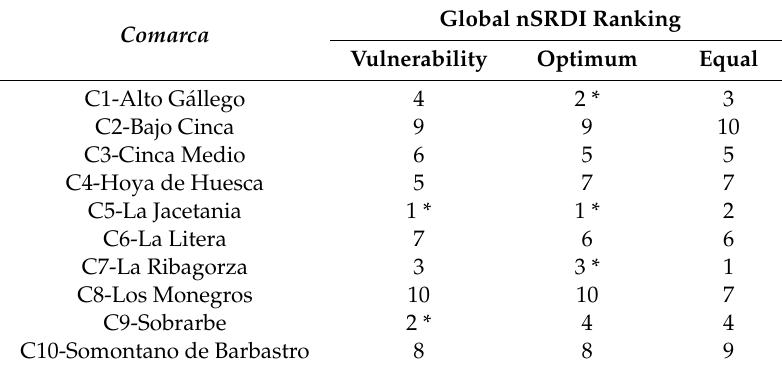
Table 4. Global new Sustainable Rural Development Index—nSRDI rankings of comarcas for weights calculated with the vulnerability, equal and optimal